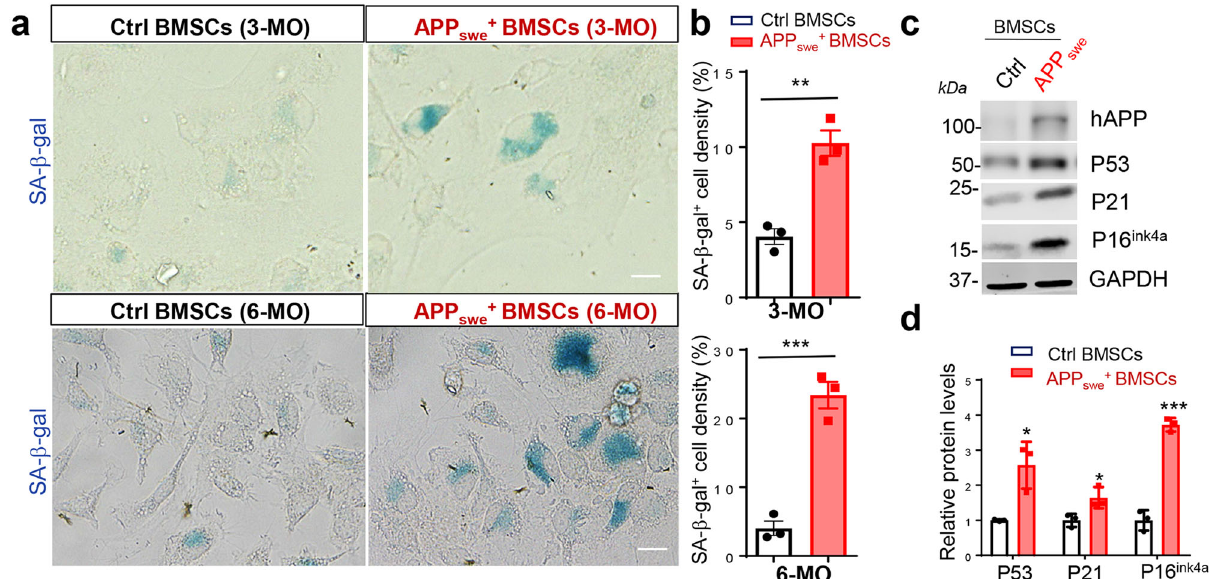
Fig. 6 Increased cellular senescence in APP swe + OB-lineage cells. a SA- β -gal staining of 3-MO and 6-MO BMSCs from control ( LSL-APP swe ) and TgAPP swe OCN mice. Scale bar, 20 µ m. b Quanti fi cation of SA- β -gal + cell densities (mean ± SD; n = 3 independent experiments). ** p < 0.01, *** p < 0.001. c Western blot analysis of indicated protein expression in BMSCs from mice with indicated genotypes (at 6-MO). GAPDH was used as a loading control. d Quanti fi cation analyses of the data in c , * p < 0.05, *** p < 0.001. mean ± SD n = 3. Mann – Whitney U